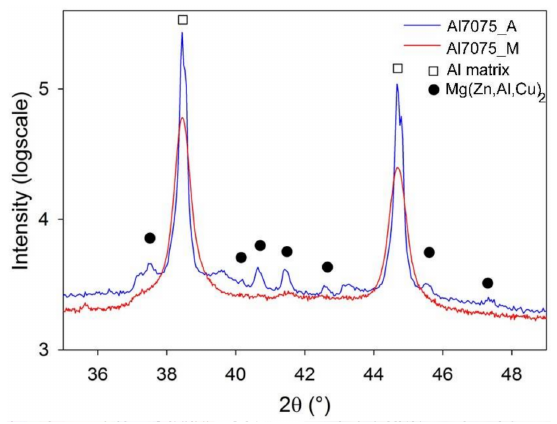
Figure 3. The X-ray diffraction (XRD) pattern of the Al7075_A and Al7075_M powders.